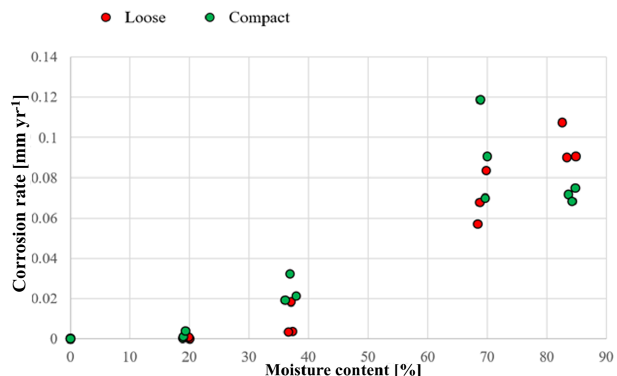
Figure 3. Corrosion rate of metal coupons as function of moisture content. Red indicators refer to loose ground. Green indicators refer to compact ground.